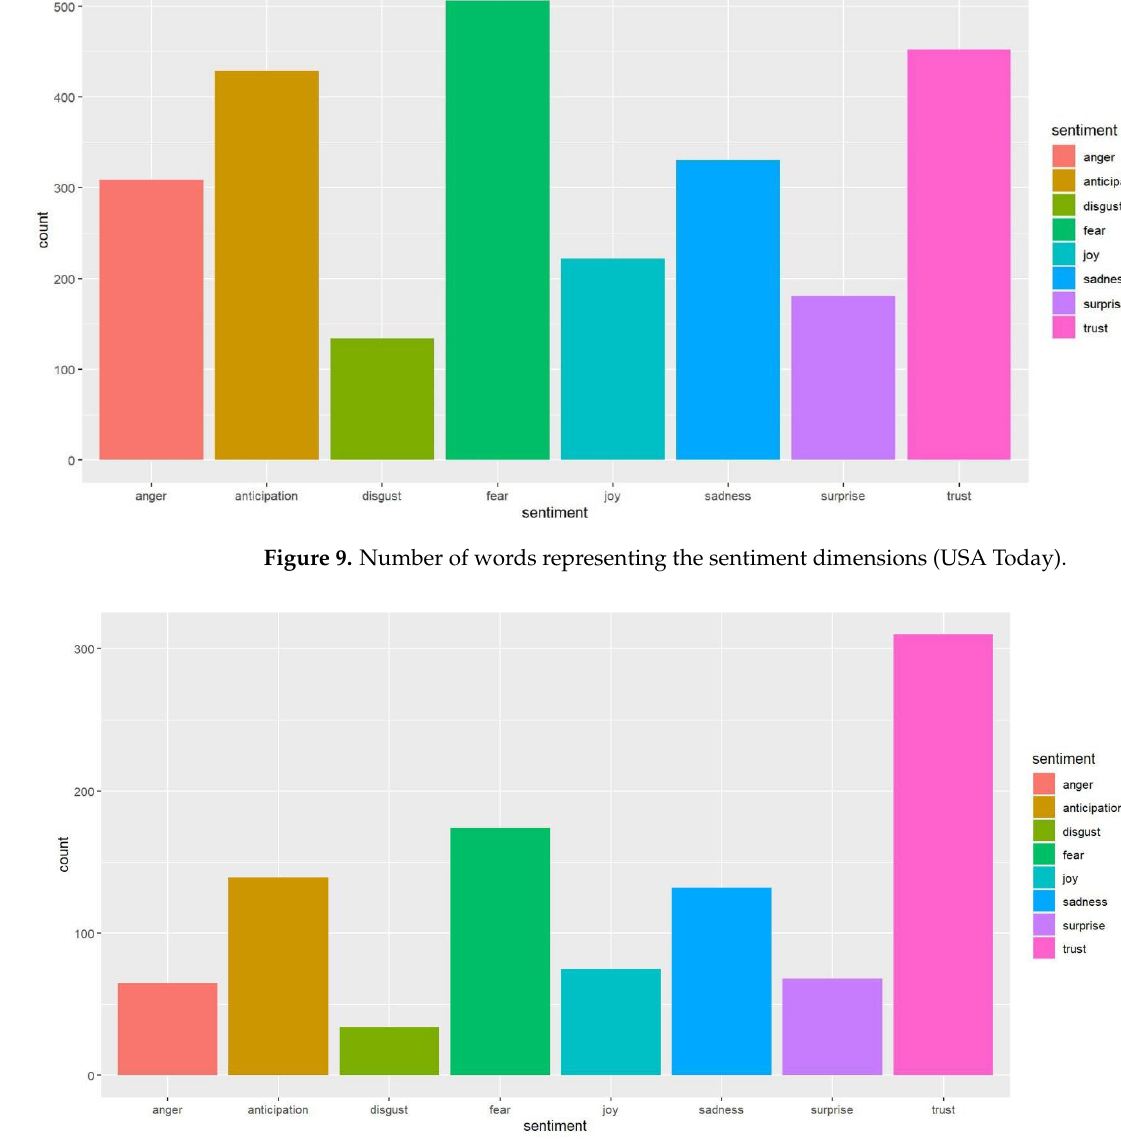
Figure 10. Number of words representing the sentiment dimensions (The Monitor).